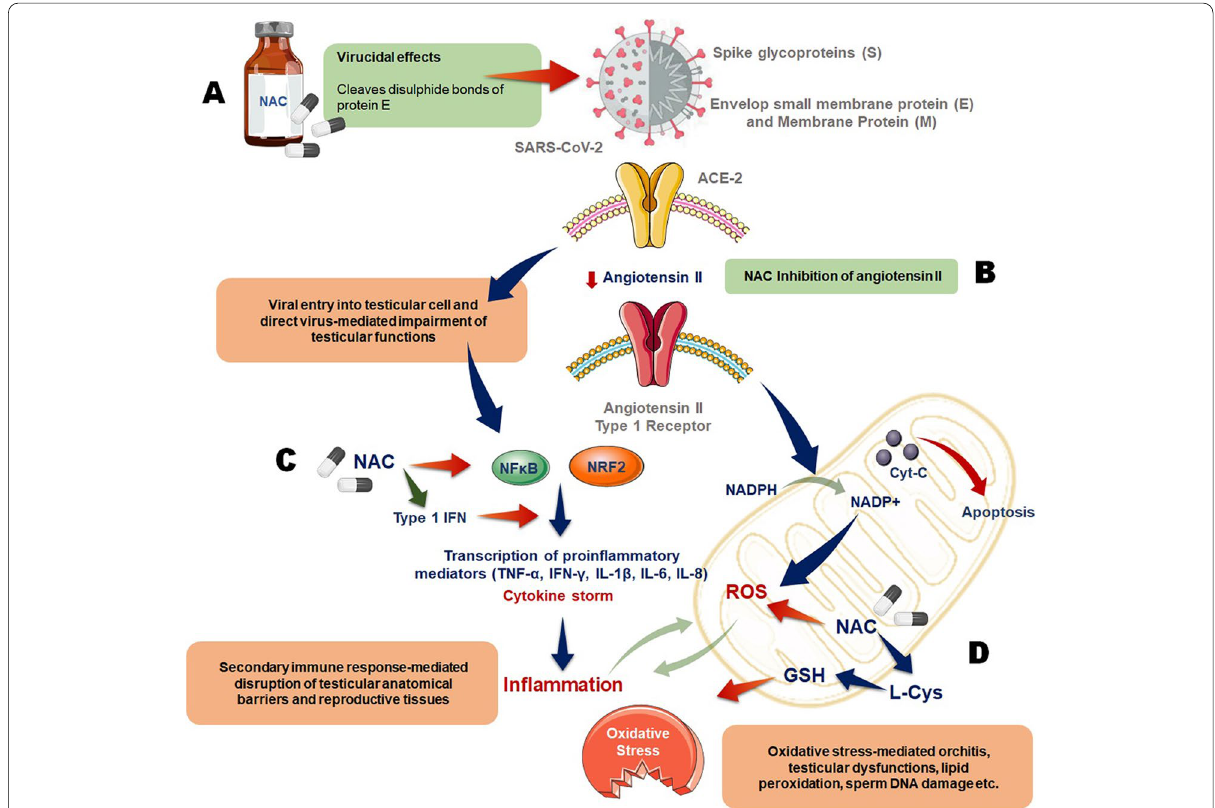
Fig. 2 Possible mechanisms of NAC-mediated protections against male reproductive disruptions caused by SARS-CoV-2 infection. A Due to presence of its free sulfhydryl group, NAC reduces the sulfide bonds in the cross-linked glycoprotein matrix in mucus thus reduced mucus viscosity and showing a mucolytic property. B NAC may reduce the binding of angiotensin II with its type 1 receptor. NAC may block imprudent synthesis of angiotensin II which cannot be converted to angiotensin 1-7 by the activation of ACE2 thus lowering the possibility and/or severity of the infection. C NAC may lead to amplification of signal cascades triggered by toll-like receptor 7 and mitochondrial antiviral signal protein in restoration of SARS-CoV-2-mediated type-I interferon (IFN) production and inhibition of NFkβ (nuclear factor kappa B) mediated upregulation of pro-inflammatory genes. D Being a potent antioxidant, NAC may exert direct effects on some reactive oxygen species (ROS), whereas it is a precursor of cysteine (an essential substrate for glutathione synthesis) and also regulates the redox state by maintaining the thiol